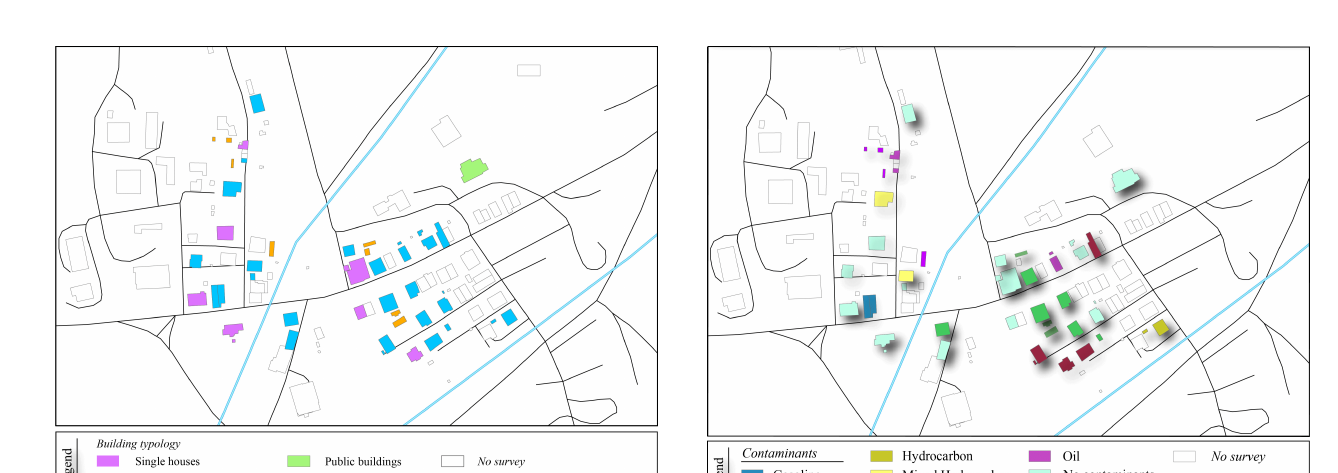
Fig. 3. Flood zone in Orvieto.